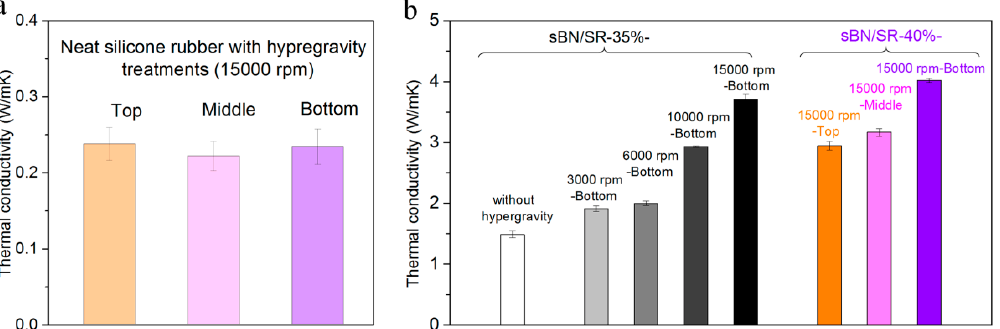
Figure 6. Comparison studies on the thermal conductivity of neat silicone rubber and BN/SR composites. ( a ) The through ‐ plane thermal conductivity of neat silicone rubber prepared with hypergravity treatments. ( b ) The through ‐ plane thermal conductivity of h ‐ BN/SR and sBN/SR composites prepared with different methods.